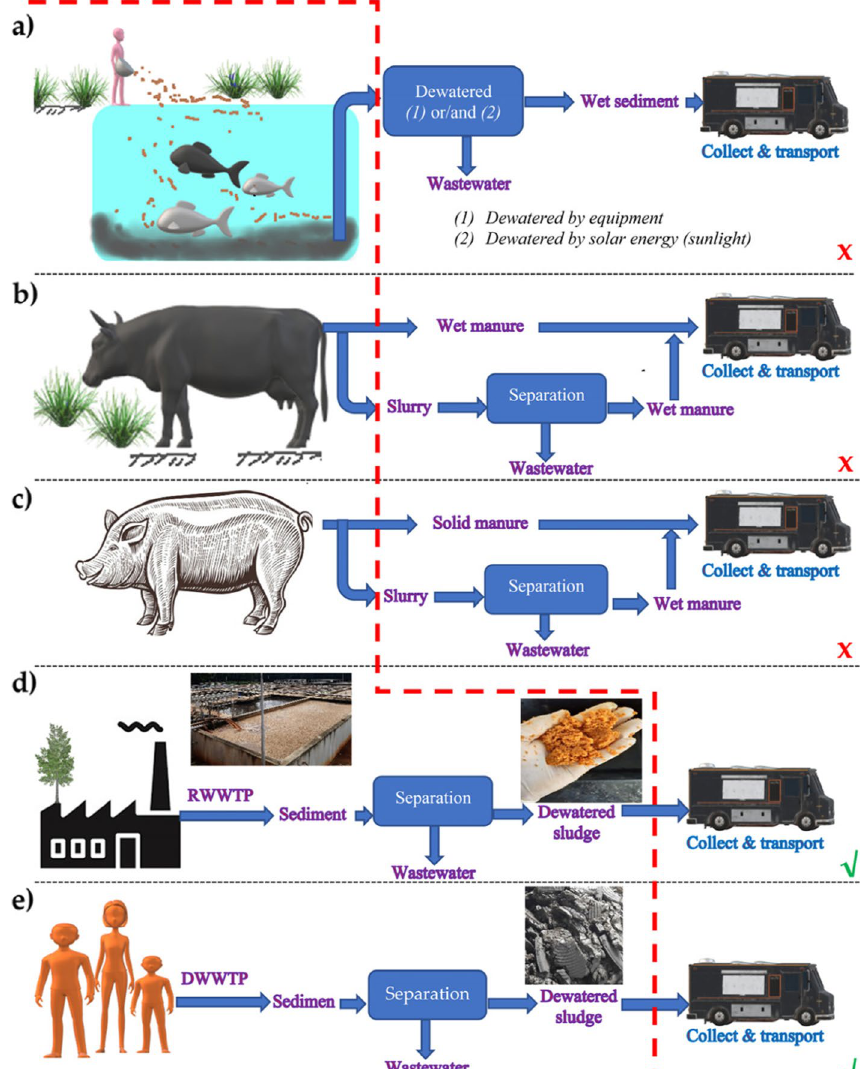
Fig. 7 Schematic representation of waste production, current treatment, and transport